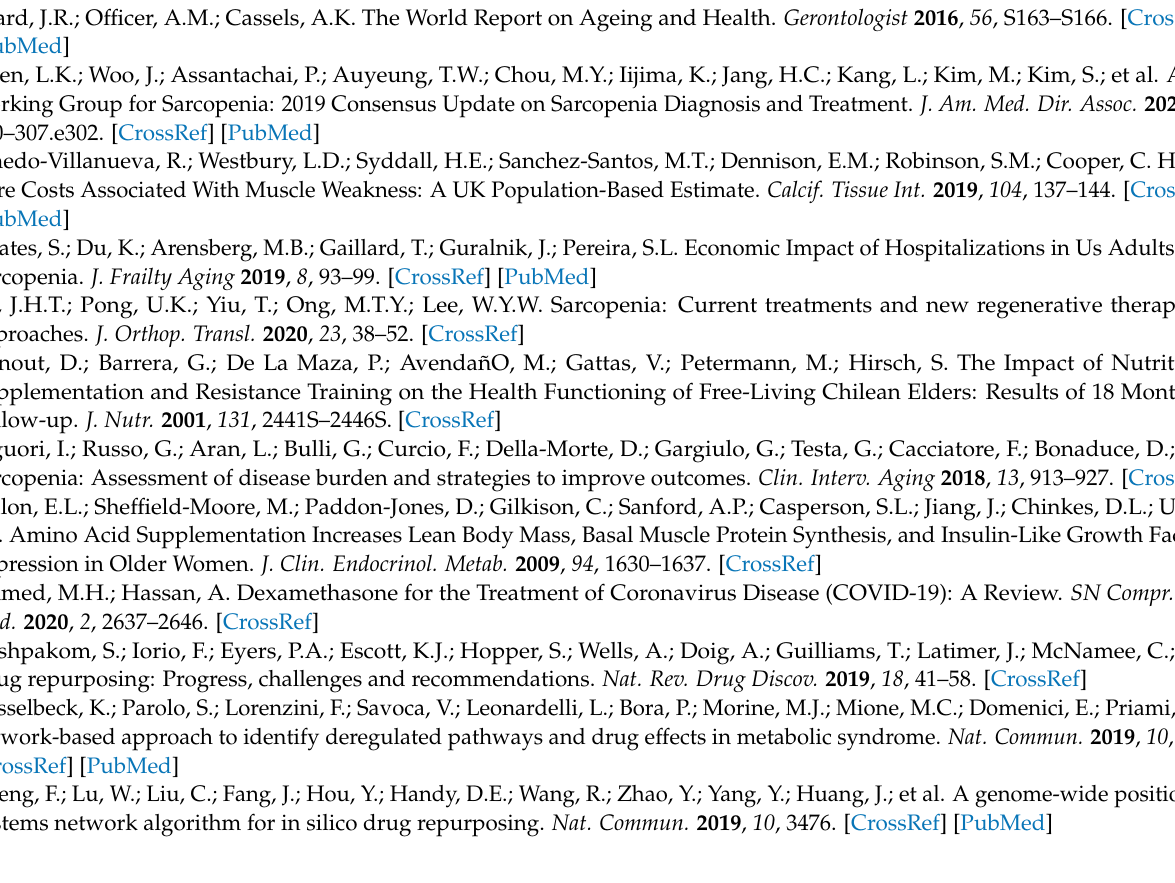
Table S2: Green module gene; Table S3: The result of drug repurposing with LINCS algorithm; Table S4: Sarcopenia-associated genes were obtained from the Open Targets and the DisGeNET database; Table S5: The result of drug repurposing with gene2drug algorithm; Table S6: The result of drug repurposing with pathway2drug algorithm; Table S7: The result of the Crank